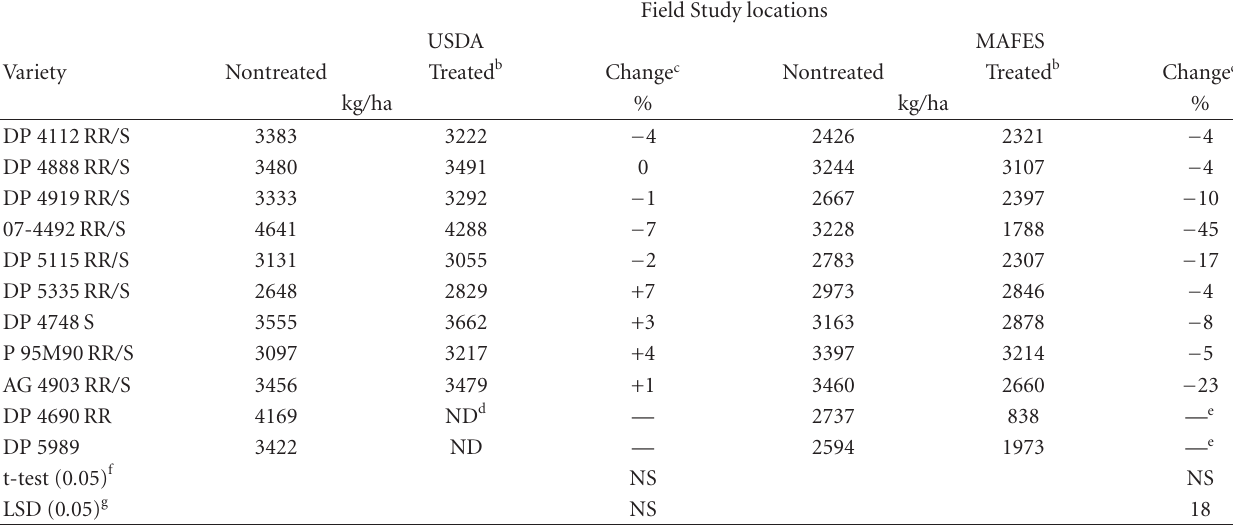
Table 2: E ff ect of halosulfuron on yield of soybean varieties with and without sulfonylurea- tolerant trait in the field studies conducted in Stoneville, Miss, USA in 2007 a .